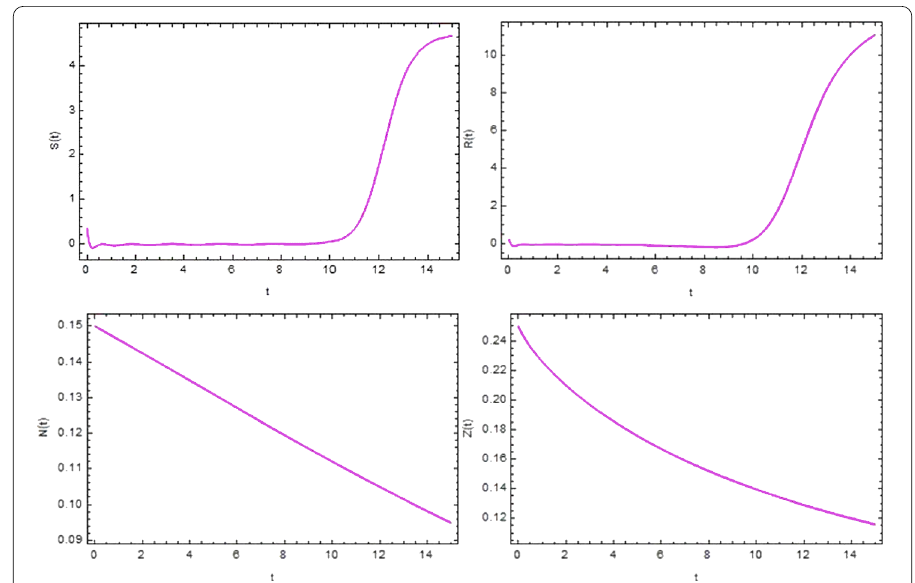
Figure 1 Numerical solution curves of the fractional-order differential system of